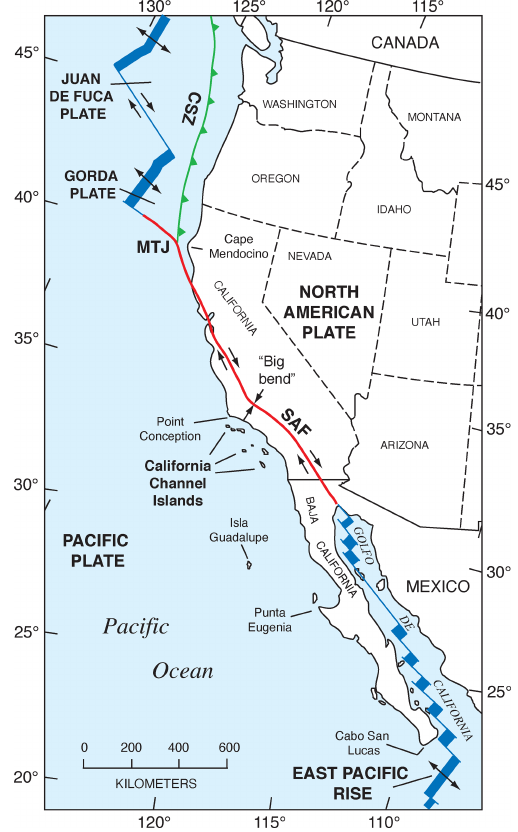
Figure 2. Tectonic setting of the Pacific coast of North America, from southern Canada to southern Baja California Sur, Mexico, showing plates, plate boundaries, structures, and localities referred to in the text. Redrawn in simplified form from Drummond (1981) and Simkin et al. (2006). CSZ: Cascadia Subduction Zone; MTJ: Mendocino Triple Junction; SAF: San Andreas